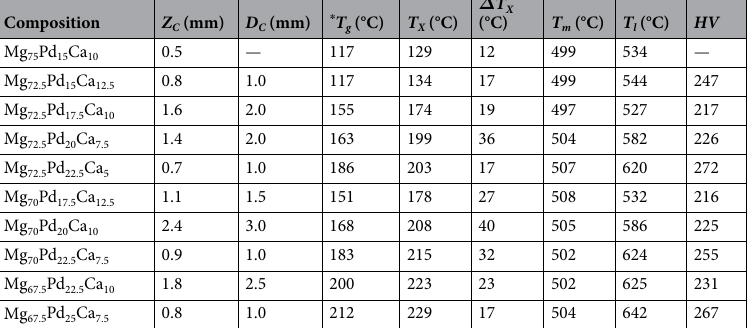
Table 3. BMG-forming compositions in the Mg-rich region of the Mg–Pd–Ca ternary system, and their associated critical casting sizes, thermophysical properties, and Vickers hardness. * T g values quoted here are the onset temperatures of the glass transition.